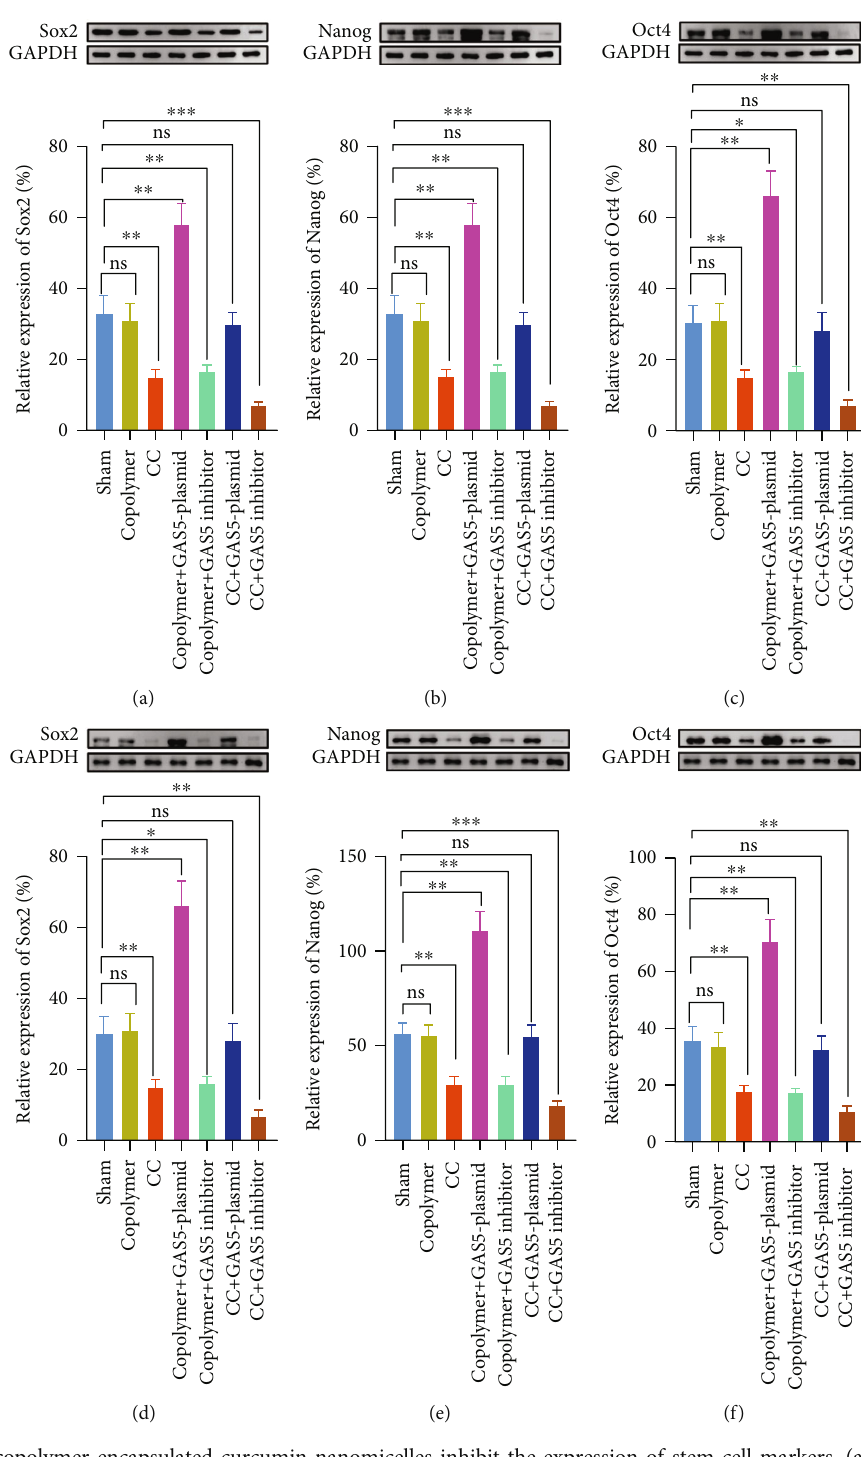
Figure 6: Triblock copolymer-encapsulated curcumin nanomicelles inhibit the expression of stem cell markers. (a – c) The expression of stem cell markers Sox2 (a), Nanog (b), and Oct4 (c) in plasma. (d – f) The expression of stem cell markers Sox2 (d), Nanog (e), and Oct4 (f) in brain tissue ( ∗ P < 0 : 05 , ∗∗ P < 0 : 01 , and ∗∗∗ P < 0 : 001 ; ns: not signi fi